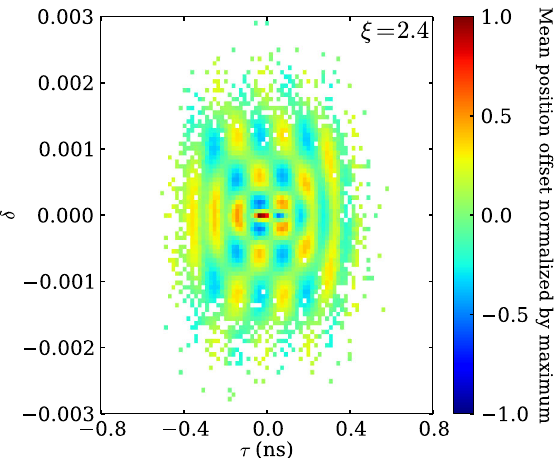
FIG. 13. Scatter plot of populated bins in synchrotron phase space for the flat potential condition at the end of a macroparticle simulation of a coupled-bunch instability at a chromaticity of 2.4. The color of each point represents the mean offset of particles within that